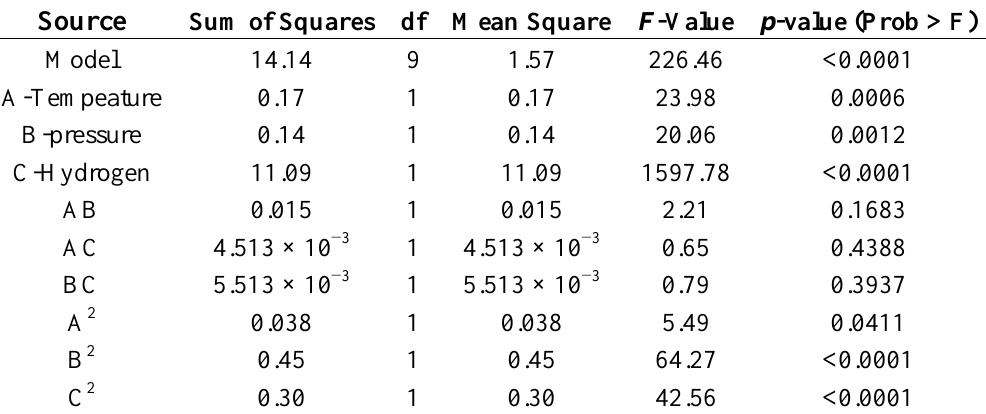
Table 4. Statistical parameters for sequential models.